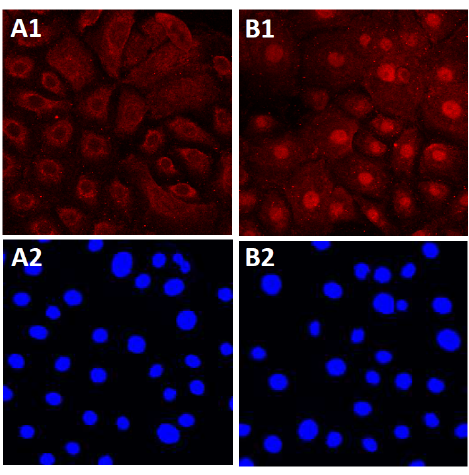
Figure 1. Activation of AHR. In untreated normal human keratinocytes, AHR (red) is mainly located in the cytoplasm ( A1 ). Nuclei are stained with 4 ′ ,6 ‐ diamidino ‐ 2 ‐ phenylindole (blue, A2 ). In the presence of soybean tar glyteer, AHR is translocated from the cytoplasm to the nucleus ( B1 , red). Nuclei are stained with 4 ′ ,6 ‐ diamidino ‐ 2 ‐ phenylindole (blue, B2 ).